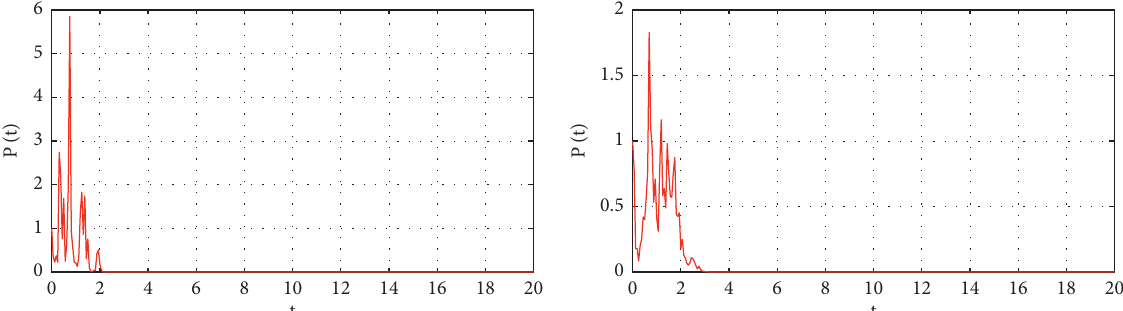
Figure 2: The trajectories of system (91) with P � 1 ,H � 0 . 3. (a) θ � 1 , u � 3 ,v � 2. (b) θ � − 1 , u � 1 ,v � 1. The trajectories of system (91) 0 are almost surely exponentially stable for both (a) and (b) in the sense of Theorem 5 (i).